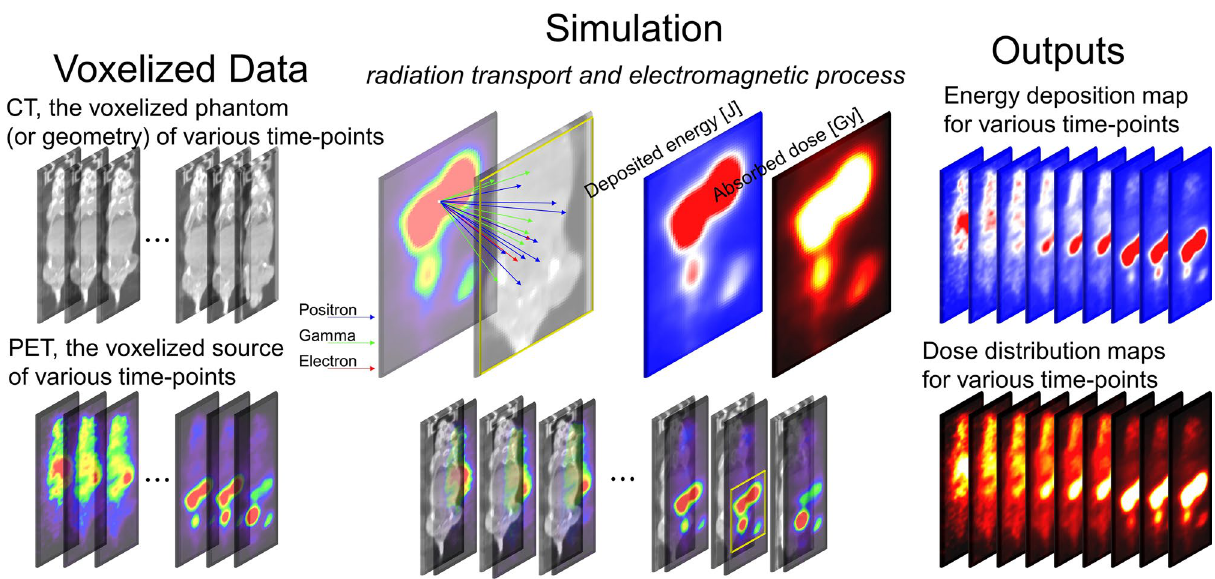
Figure 5. Graphical diagram illustrating how a dose map is generated. GATE simulates electromagnetic physical processes, such as the Photoelectric effect, Compton scattering, Rayleigh scattering, Pair production, Ionization, Bremsstrahlung, Positron and electron annihilation, Single and multiple Scattering and Muon electromagnetic processes for annihilated particles (positron, gamma, electron, etc. depending on the radioisotope) according to the radioactive decay. The trajectories of the particles originate at the specific voxel and the destination is a random voxel. The DoseActor mechanism embedded in GATE estimates the deposited energy and the dose map. Finally, the absorbed doses in the voxels are calculated by dividing the deposited energy in each voxel by the voxel